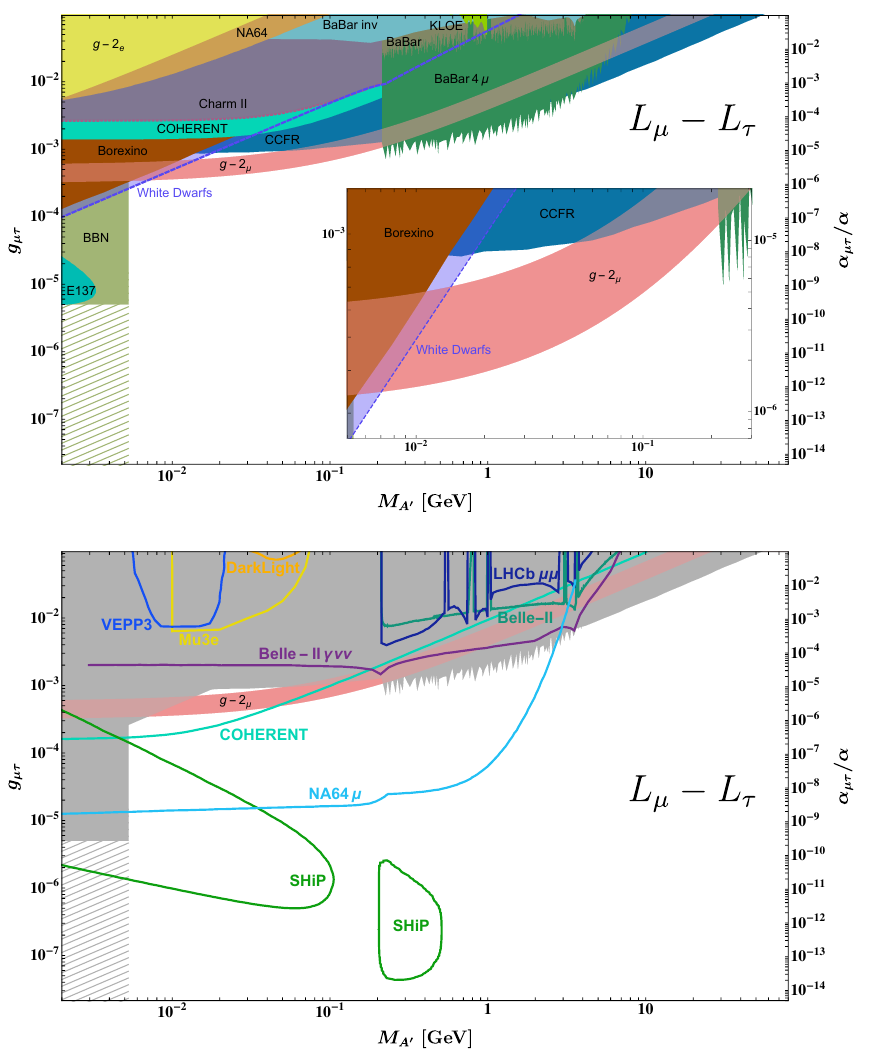
Figure 16 . Constraints from current (upper panel) and future (lower panel) experiments on a U(1) L gauge boson with gauge coupling g (cid:22) (cid:22) (cid:0) L (cid:28) cooling are not shown (see section